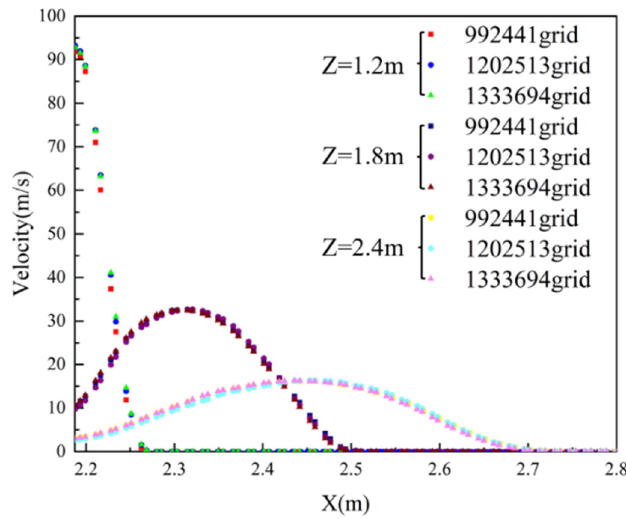
Figure 3. Effect of grid number on the impinged surface velocity.